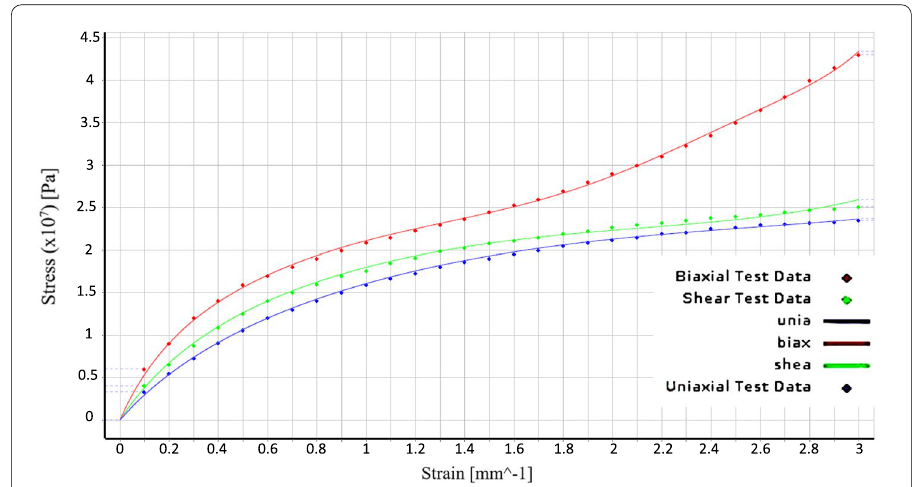
Fig. 5 Polyurethane material model for all deformation modes (uniaxial, biaxial, and shear test data) using MR 9 parameter model to evaluate the C ij constants